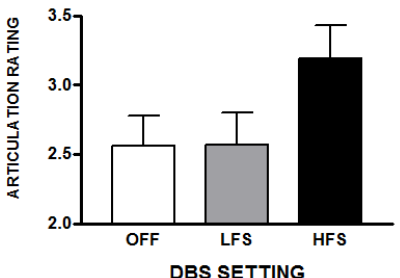
Figure 4. The average subjective ratings of articulation abnormalities (with standard errors) that raters reported for a set of spontaneous speech samples obtained during the three STN-DBS conditions. These samples were not used for the transcription task but were used for the voice, articulation, fluency, and rate judgments. The scale was 1 (normal) to 5 (abnormal).